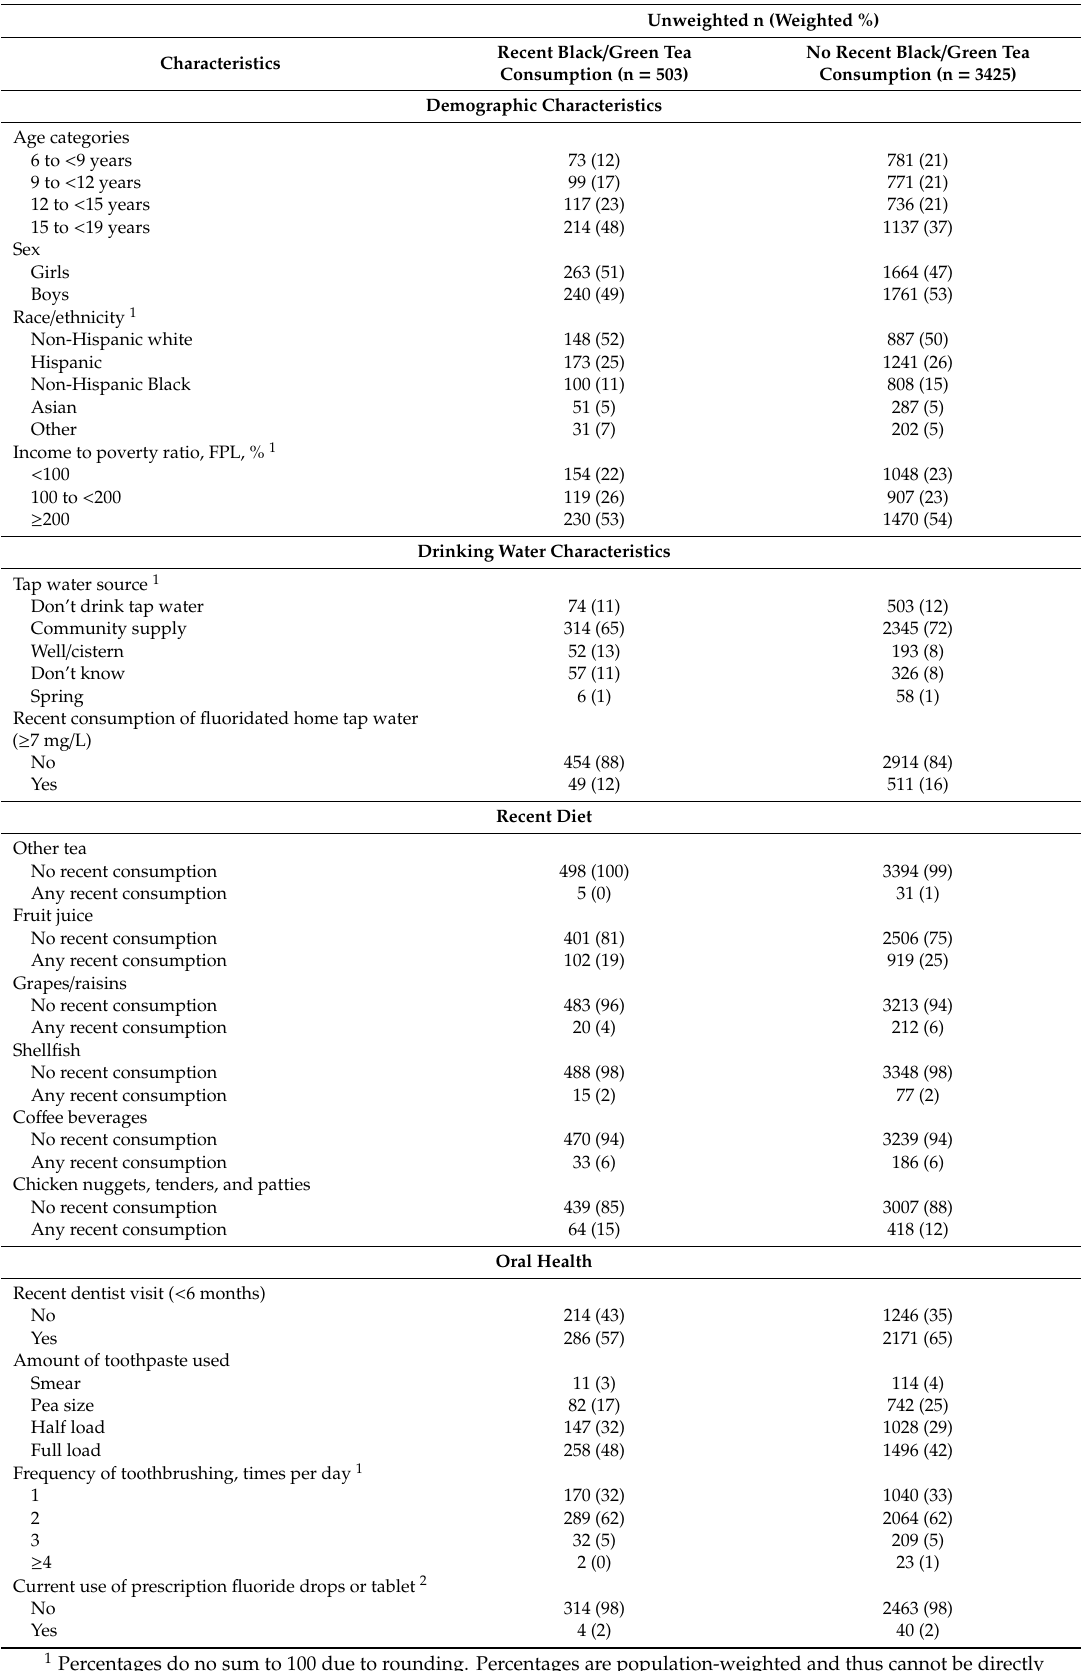
Table A2. Characteristics of 6–19 year old respondents, by recent green / black tea consumption, National Health and Nutrition Examination Survey,